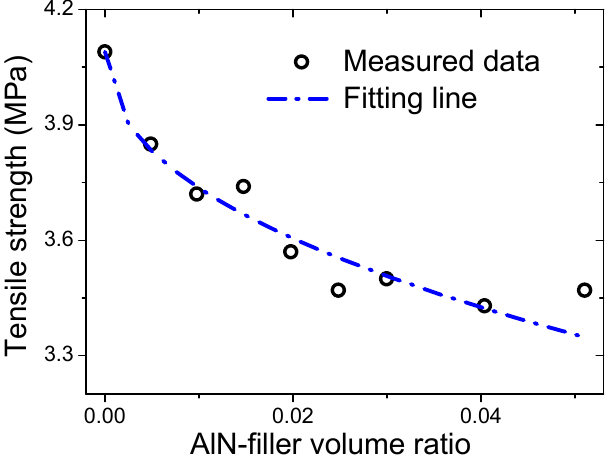
Figure 5. Fitting results of the tensile strength of the composites based on a power-law model.